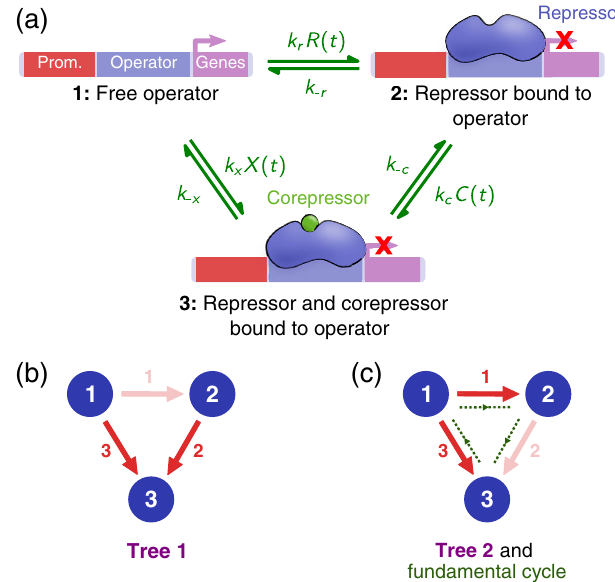
FIG. 5. (a) Biochemical network of a repressor-corepressor model, showing an operator site on DNA in three different states: (1) free, (2) bound to a bare repressor protein, (3) bound to a represssor-corepressor complex. Transition rates between the states are shown in green. The binding reaction rates depend on three concentrations of molecules in solution: R ð t Þ for bare repressors, C ð t Þ for corepressors, and X ð t Þ for the complexes. (b) One of the spanning trees for the associated network graph, with the edge deleted to form the tree shown in faint red. We take this to be the reference spanning tree for the tree basis. (c) The other tree in the basis, with the corresponding fundamental cycle in